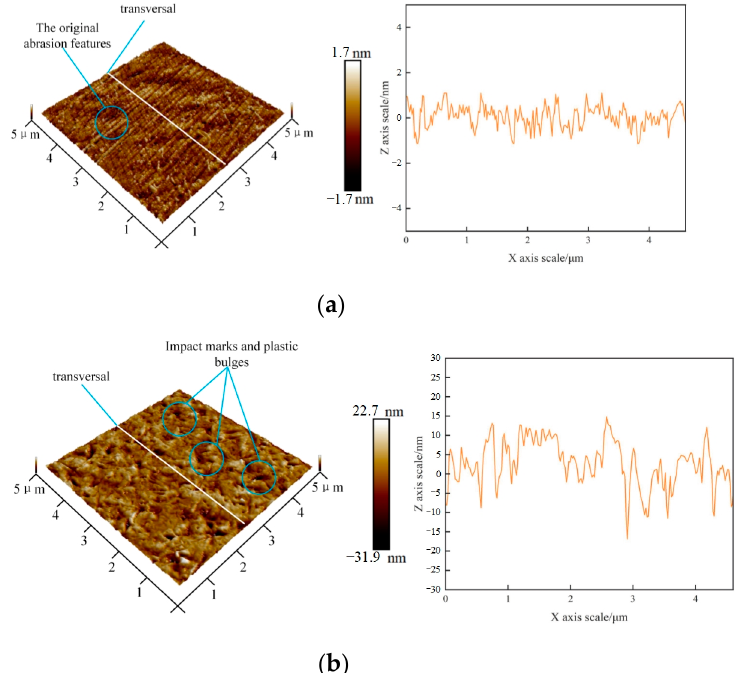
Figure 7. Comparison of microscopic morphology. ( a ) Original morphology and cross-section profile of the workpiece. ( b ) Workpiece morphology and cross-section profile after 0.3 A current processing.